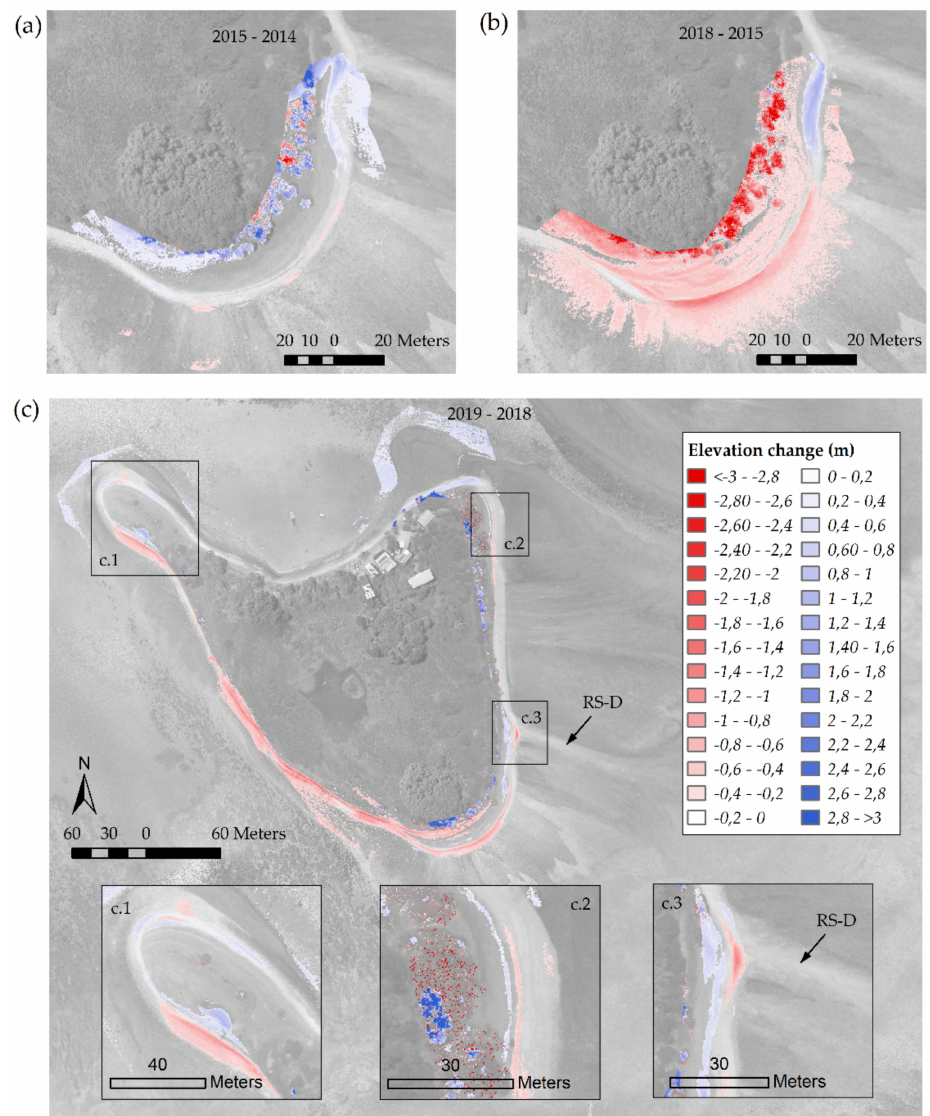
Figure 10. ( a ) 2015–2014 DoD, ( b ) 2018–2015 DoD, and ( c ) 2019–2018 DoD. Background image: 2018 LiDAR mosaic. Note that the more extreme change values on the Island are due to the inclusion/exclusion of